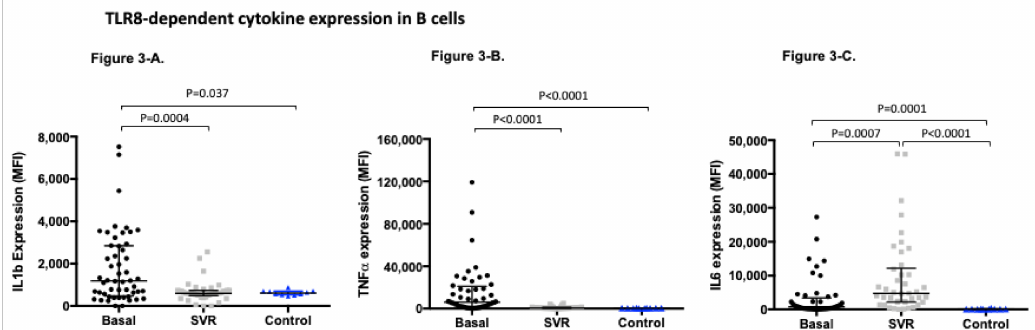
Figure 3. TLR8-dependent cytokine expression in B cells measured as mean fluorescence intensity (MFI) (median (IQR)) in HCV patients pre and post-treatment and healthy controls: ( A ). TLR8-dependant IL1b expression in B cells pre-treatment MFI (1181.0 (471.5–2845.0)) compared to post-treatment MFI (589.9 (483.1–736.4)) p = 0.0004; and compared to controls MFI (607.0 (523.6–702.7)) p = 0.037. ( B ). TLR8-dependant IL6 expression in B cells pre-treatment MFI (750.5 (207.2–3401.0)) compared to post-treatment MFI (4749.0 (2223.0–12196.0)) p = 0.0007; and compared to controls MFI (98.6 (80.9–142.3)) p = 0.0001. ( C ). TLR8-dependent TNF alfa expression in B cells pre-treatment MFI (6218.0 (1922.0–21013.0]) compared to post-treatment MFI (487.0 (286.8–1077.0)) p < 0.0001; and compared to controls MFI (399.4 (305.8–509.0)) p < 0.0001.